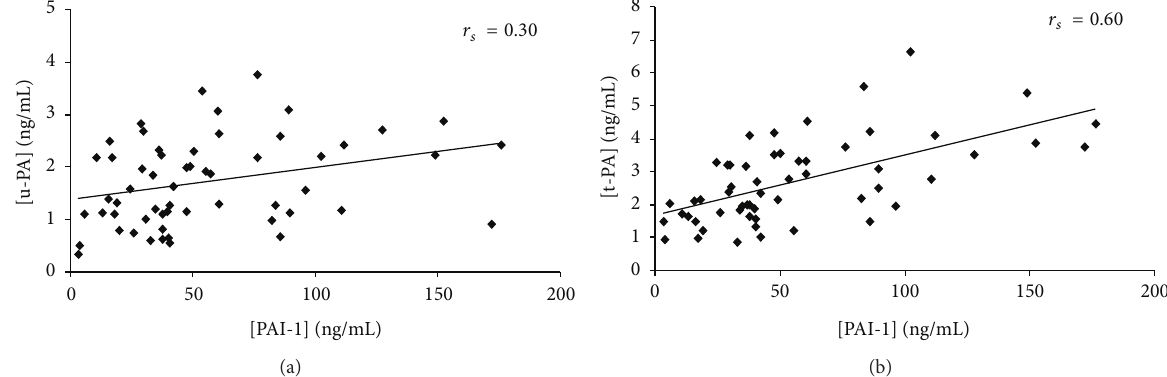
Figure2:u-PAort-PAandPAI-1levelsinconditionedmediawithaorticstenosisvalves.Correlationbetweenu-PAandPAI-1measuredlevels (a) and the t-PA and PAI-1 measured levels (b) in the conditioned media obtained with 65 aortic stenosis valves. The search for correlation was obtained by Spearman test ( 𝑟 𝑠